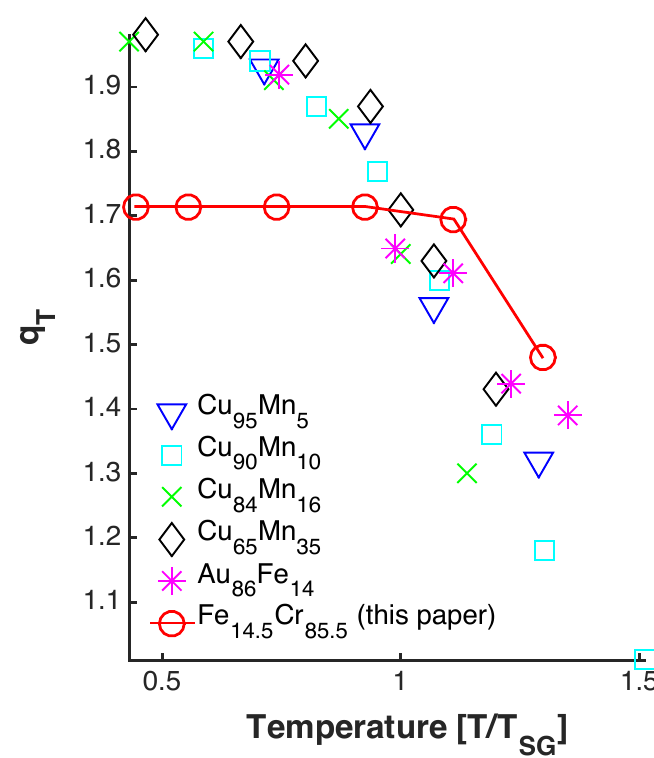
Figure 6. Comparison between data published by Pickup [5] on diluted spin glasses Au 1 − x Fe x and Cu 1 − x Mn x and the results observed in the present study on the cluster spin glass Fe 17.8 Cr 82.2